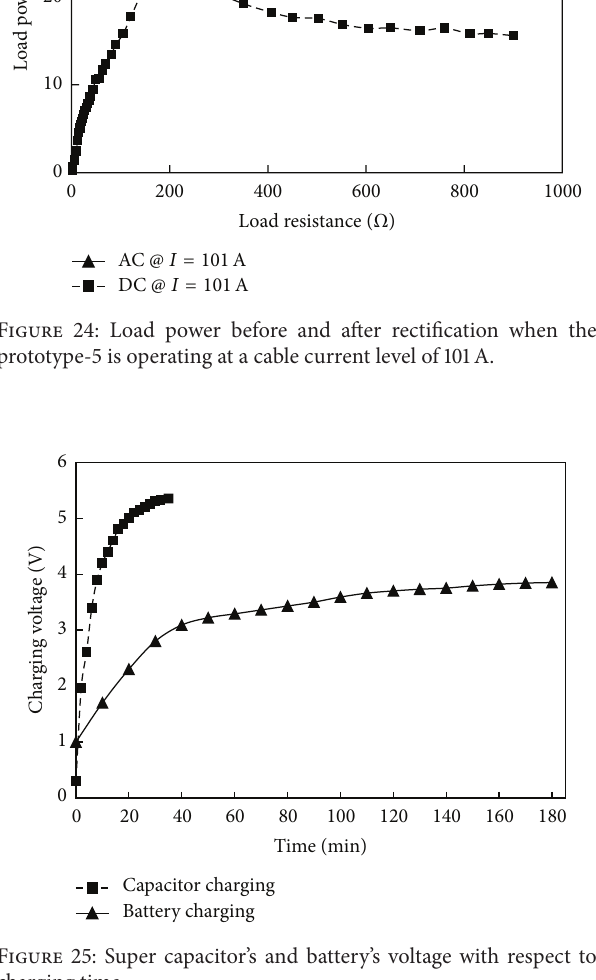
Figure 23: Load voltage and current before and after rectification when the prototype-5 is operating at a cable current level of 101A.